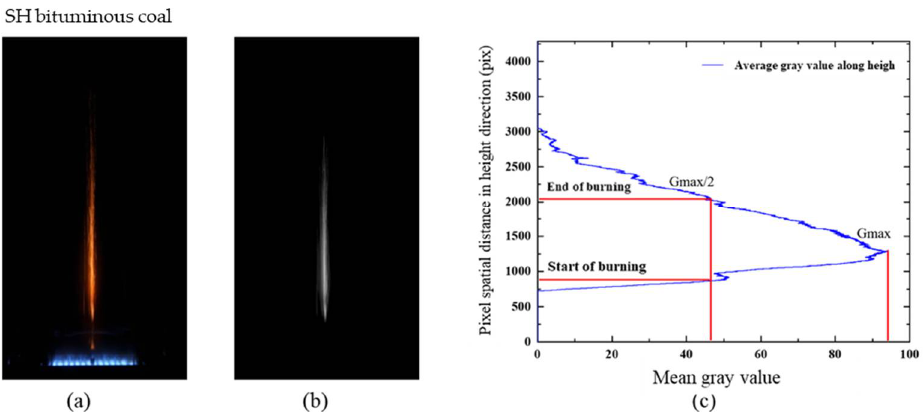
Figure 5. ( a )The long-exposure original picture; ( b )the grayscale picture after long-exposure pro- cessing; ( c ) the grayscale distribution curve along the height direction. processing; ( c ) the grayscale distribution curve along the height